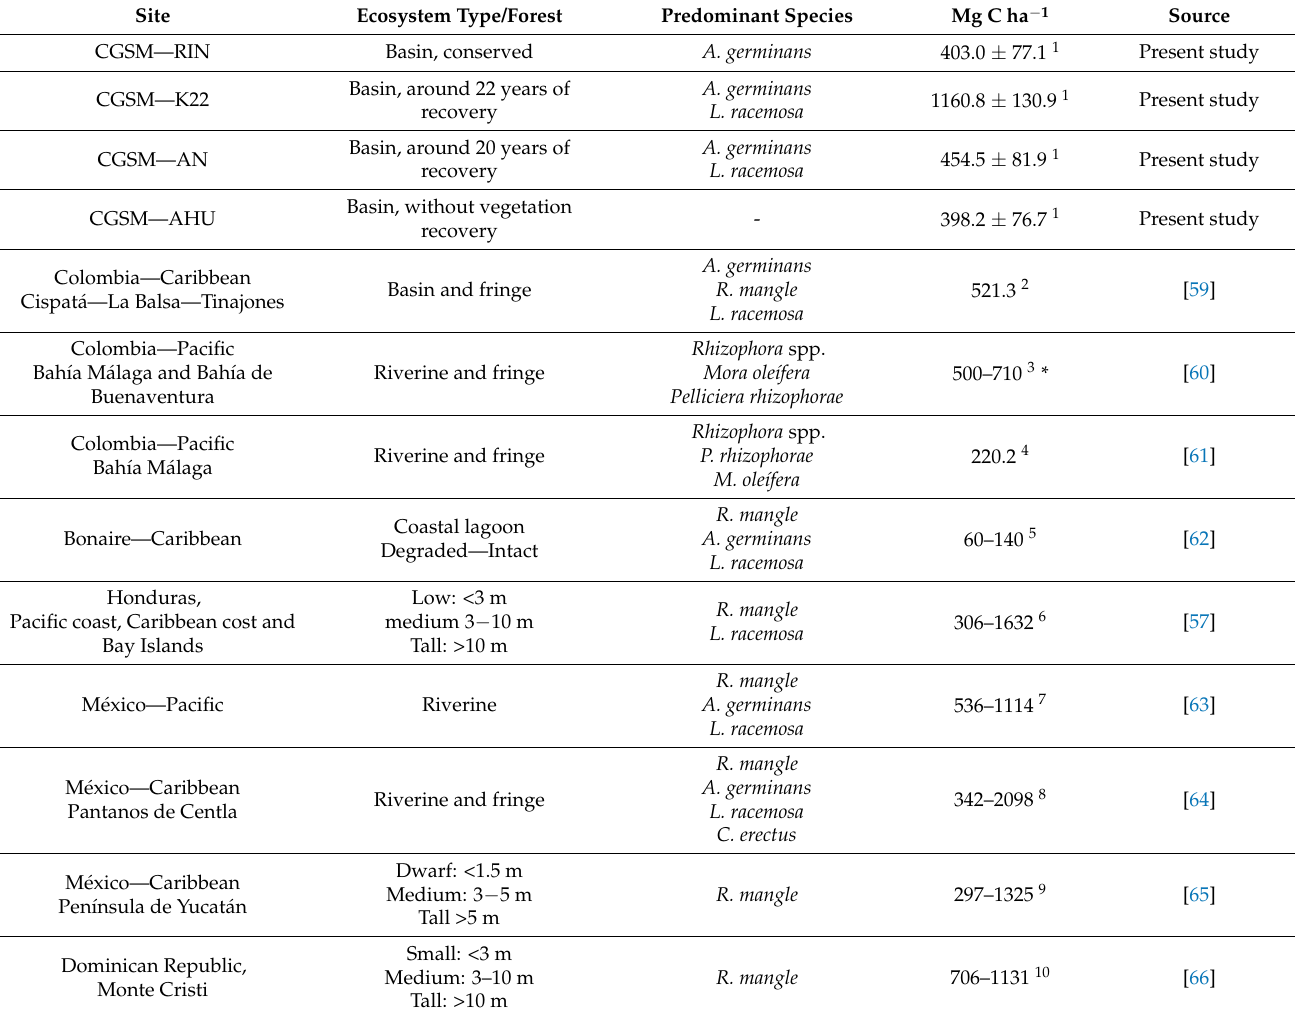
Table 6. Carbon stocks (Mg C ha − 1 ) in neotropical mangroves. CGSM = Ci é naga Grande de Santa